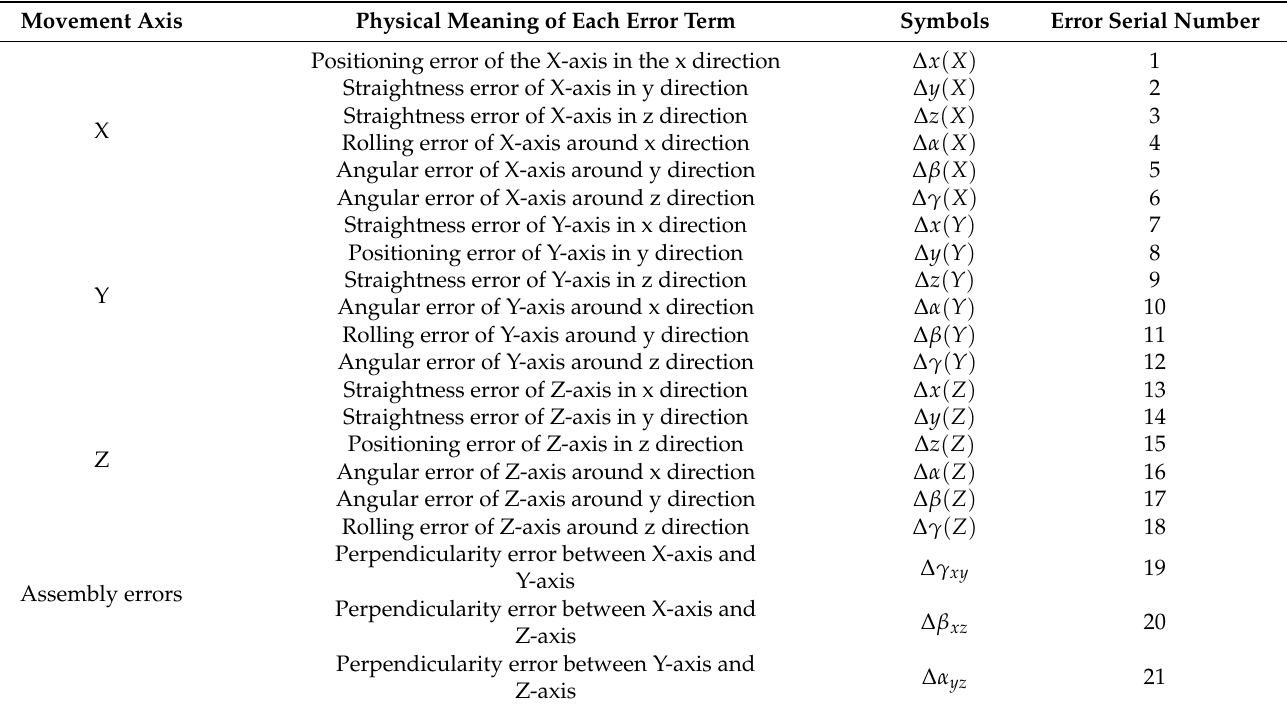
Table 1. Definition of 21 geometric